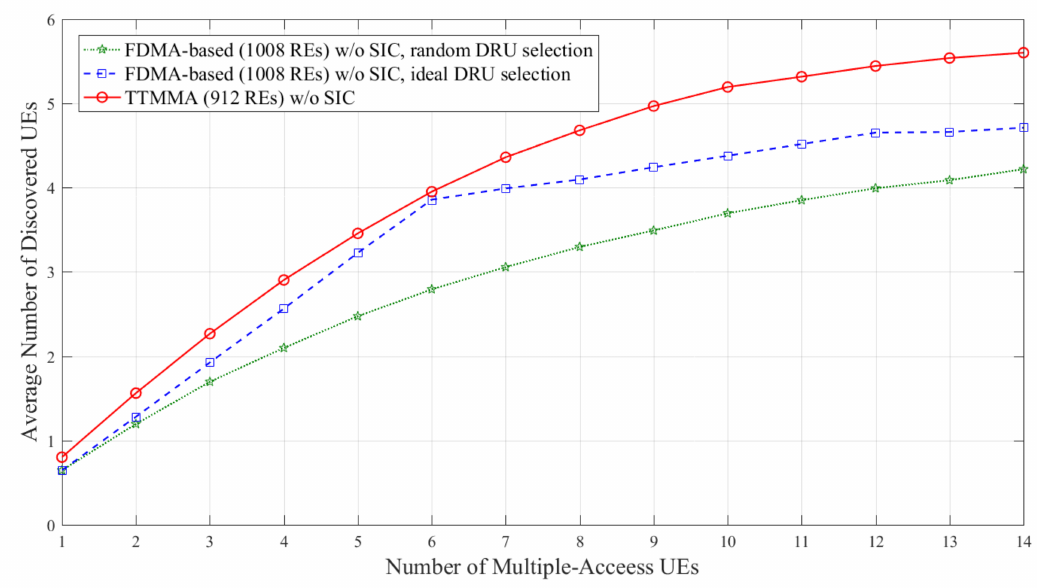
Figure 9. Average number of discovered UEs according to the number of multiple-access UEs in TDL-A channel without applying